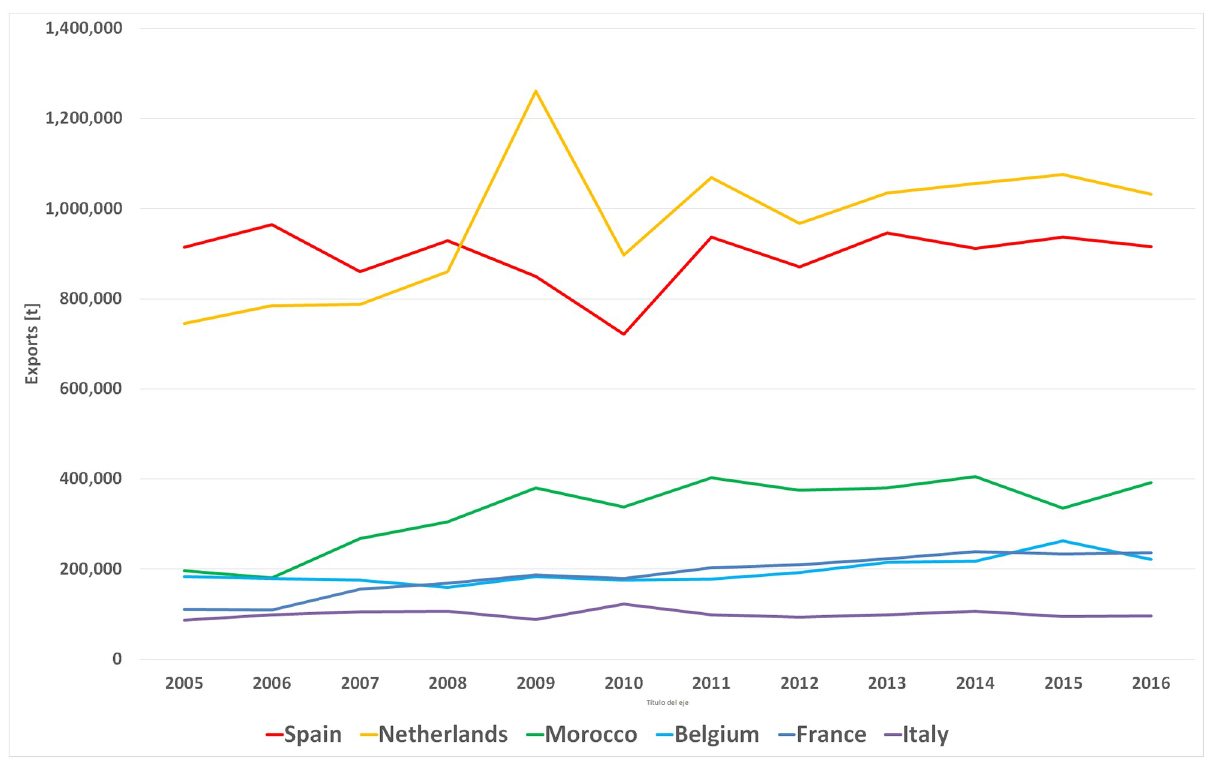
Fig 6. Evolution of the tomatoes export volume of competitors in the European market